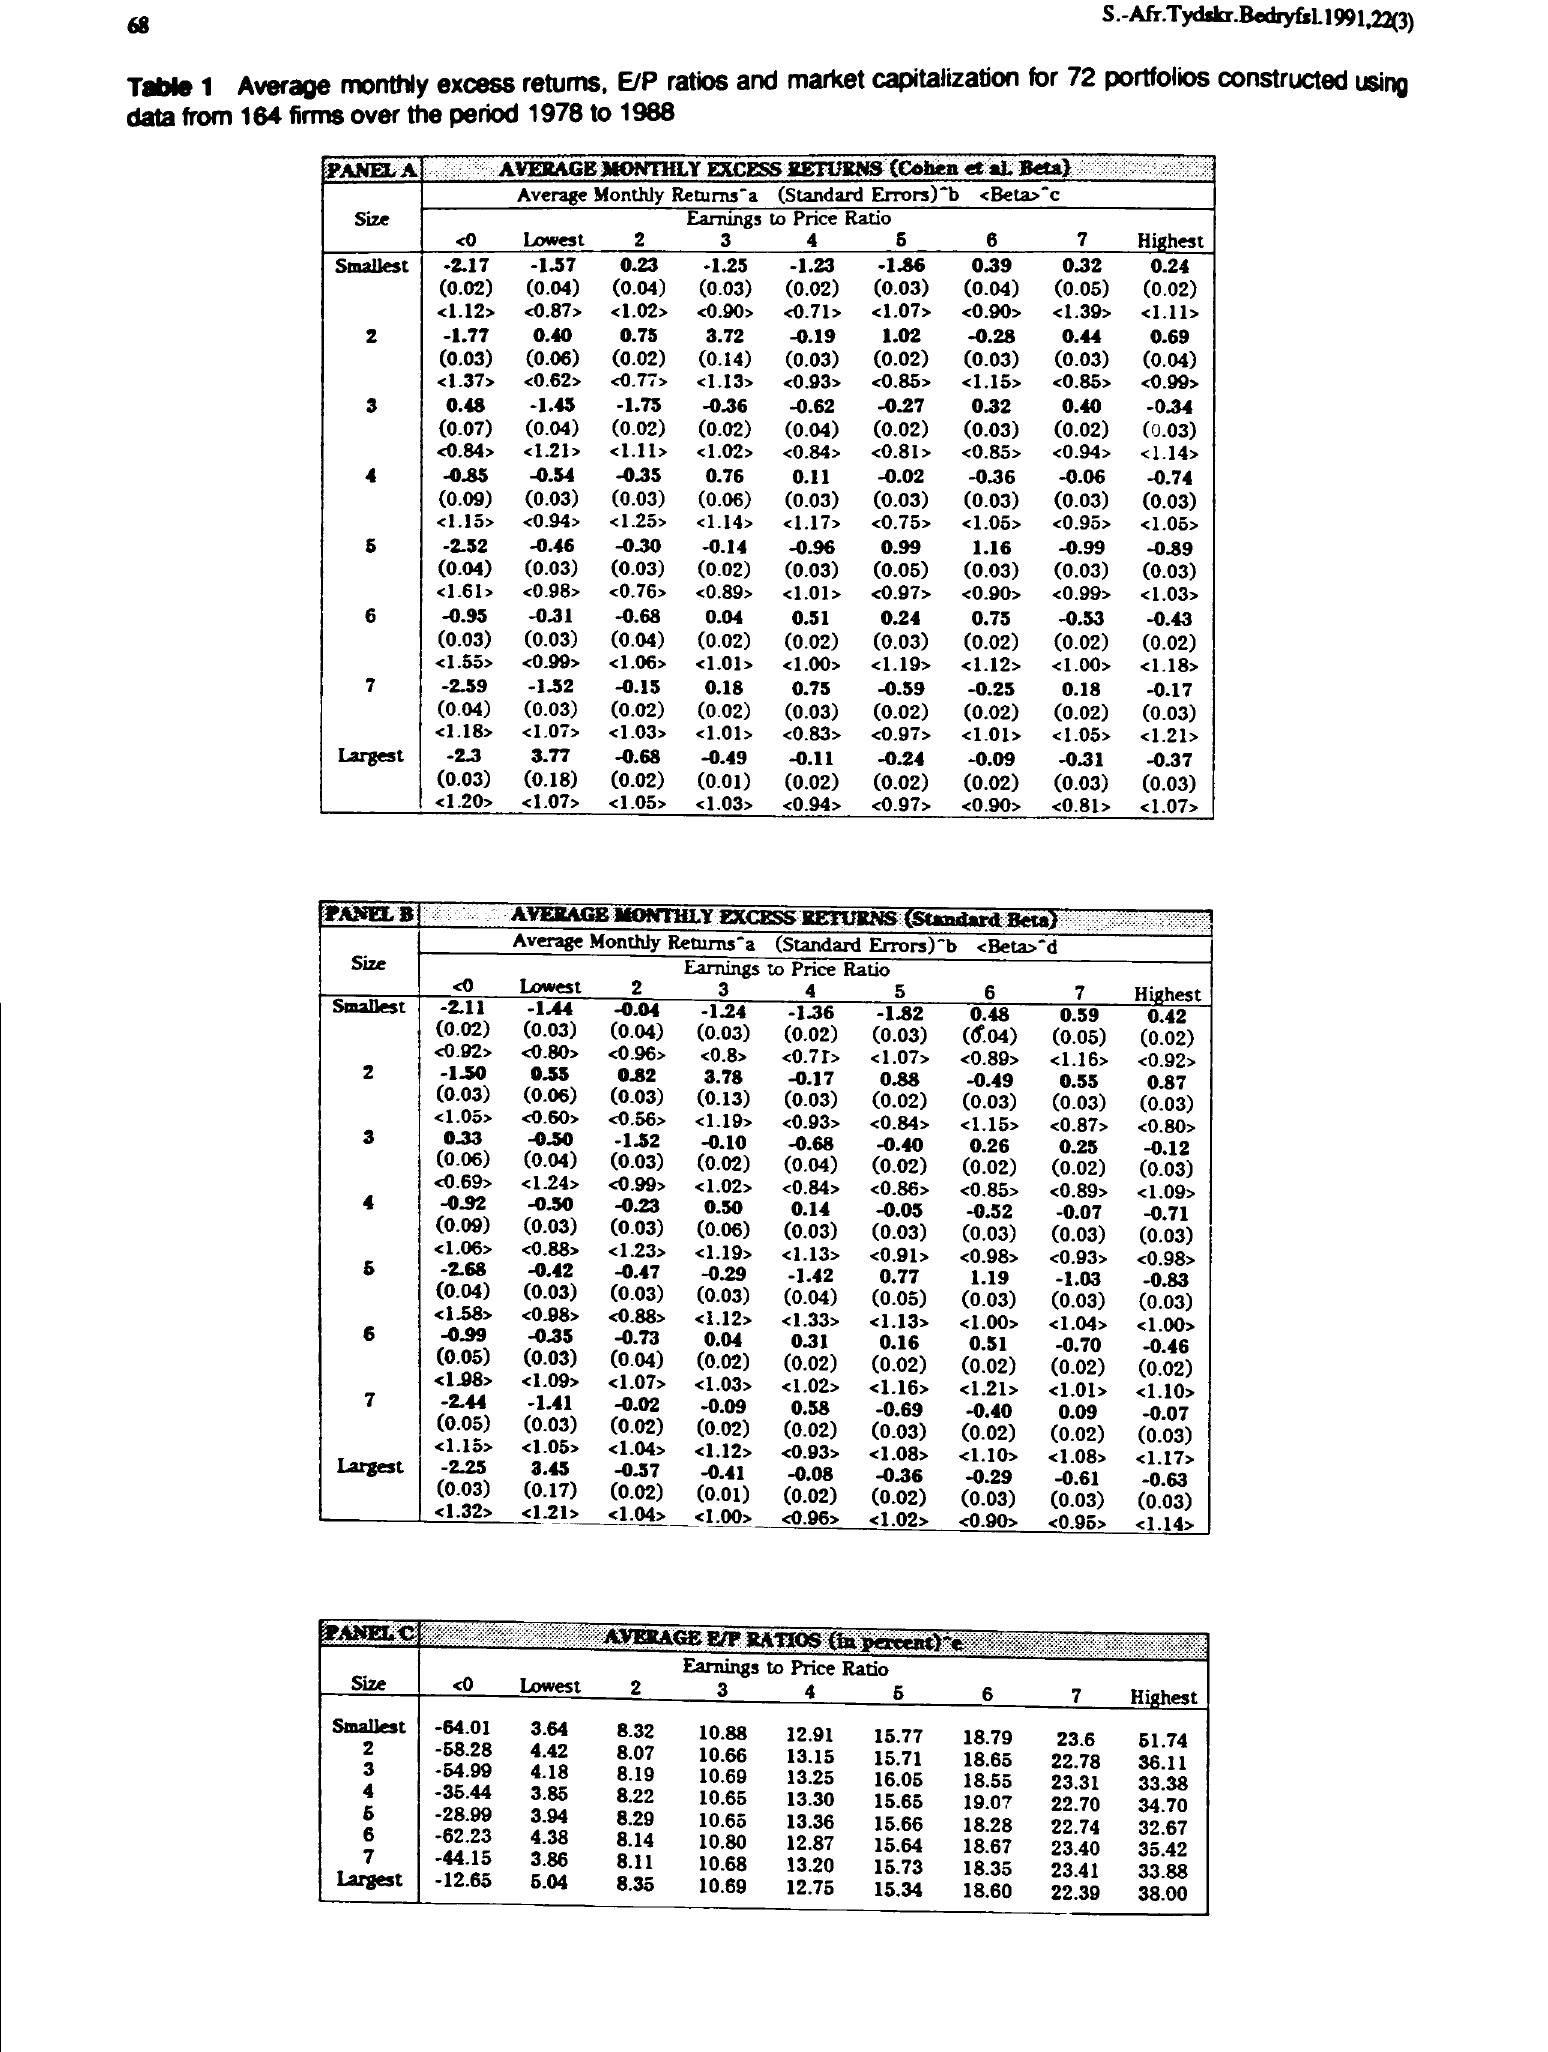
Table 1 Average monthly excess returns, E/P ratios and market capitalization for 72 portfolios constructed using data from 164 firms over the period 1978 to